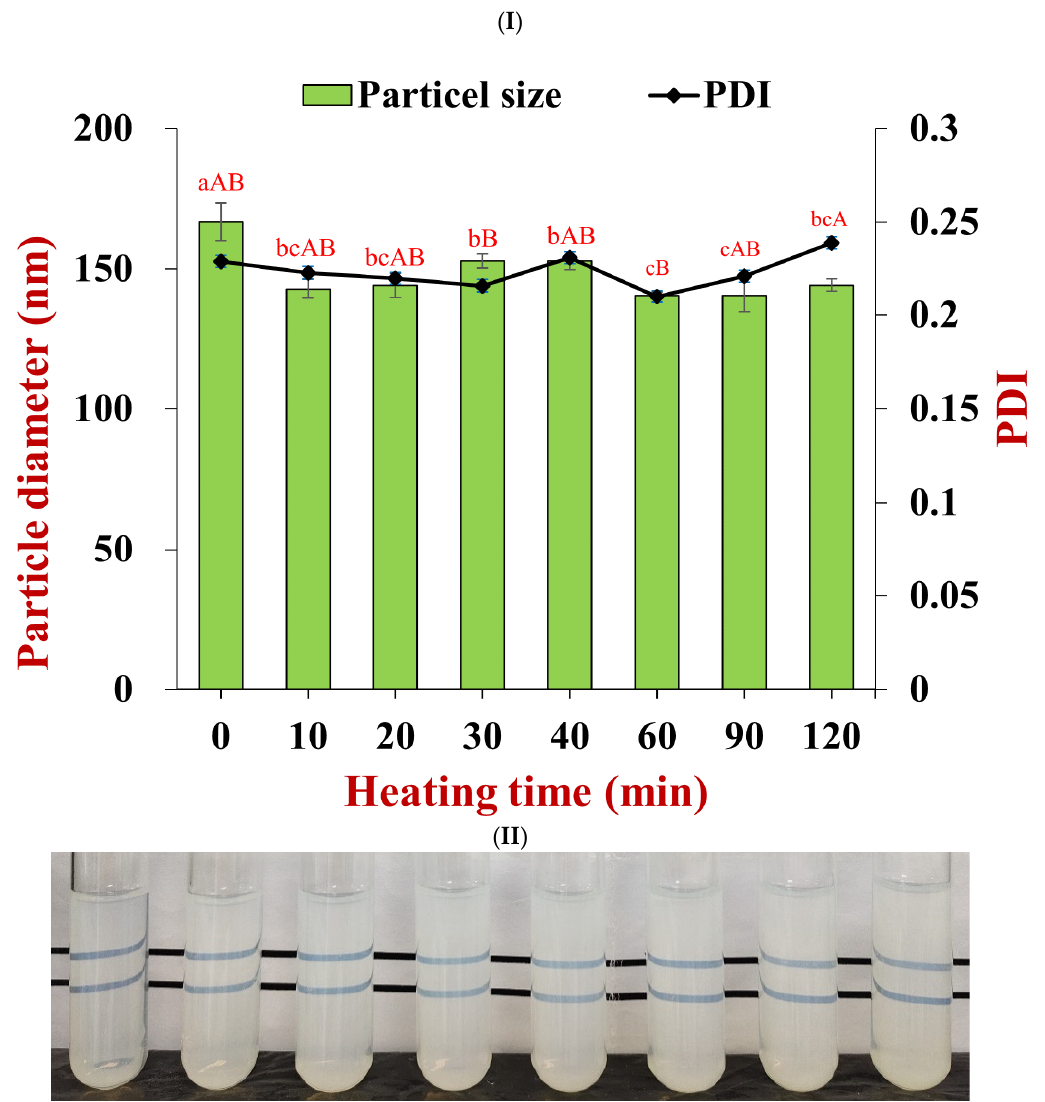
Figure 6. Particle stabilities after heating at 80 °C for 2 h. ( I ) particle diameter and PDI at different heating times (lowercase statistic notation—particle size; capital statistic notation—PDI, p < 0.05); ( II ) the appearance of particles after heat treatment. Table 1. The mean size, PDI, and ζ -potential of the nanoparticles after long-term storage. Storage Days Mean Size